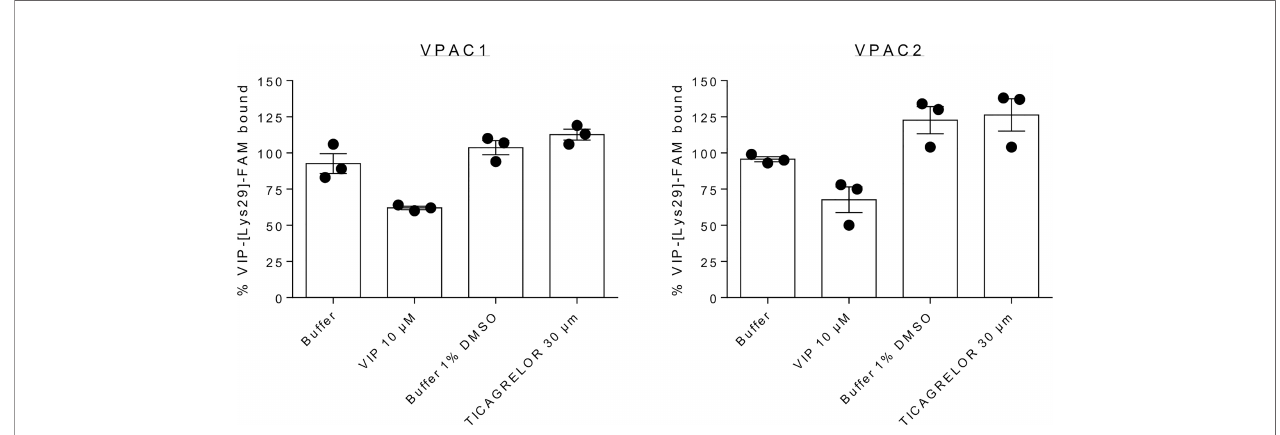
FIGURE 4 | Dissociation of VIP-[Lys 29 ]-FAM from complex formed after 30 min. incubation at 20°C with CHO cells expressing VPAC1 or VPAC2. Measured at 60 min., VIP-[Lys 29 ]-FAM remained bound after addition of 30 µM ticagrelor or corresponding buffers but dissociated after addition of 10 µM VIP – an endogenous orthosteric agonist. The presented results are the means ± SEM of 3 independent experiments performed